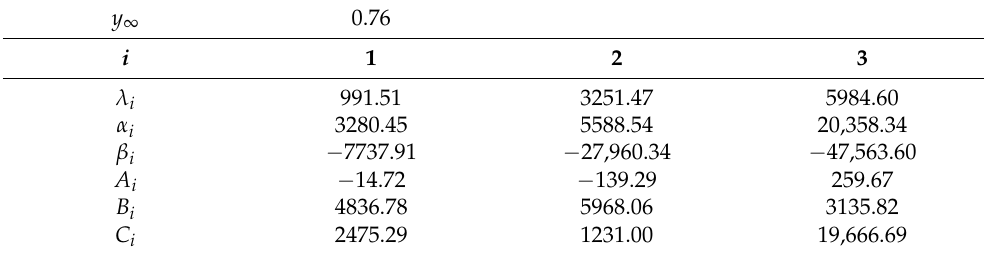
Table A1. Values of y ∞ , λ i , α i , β i , A i , B i and C i for GW.